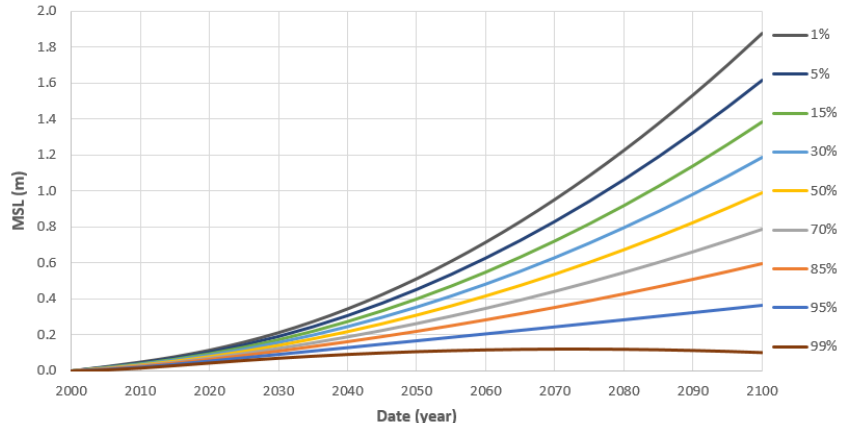
Figure 12. Absolute SLR projections (in meters) for the 21st century of the WCPM, relative to 2000, and with the local vertical velocity removed, corresponding to a discrete set of percentiles, from 1 to 99%, or the probability of not be exceeded.